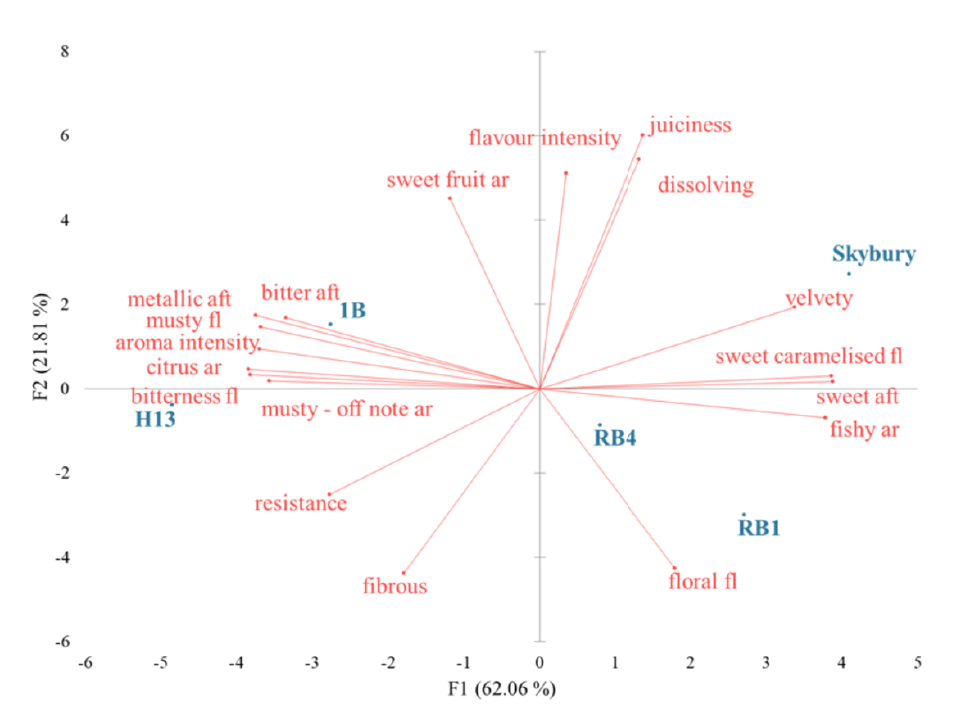
Figure 1. PCA plot of the sensory descriptive data of five papaya varieties (axes F1 and F2: 83.87%). The blue dots represent the five papaya varieties, and the red loading plots show the correlation between sensory descriptors, where ar = aroma, fl = flavour, and aft = aftertaste.